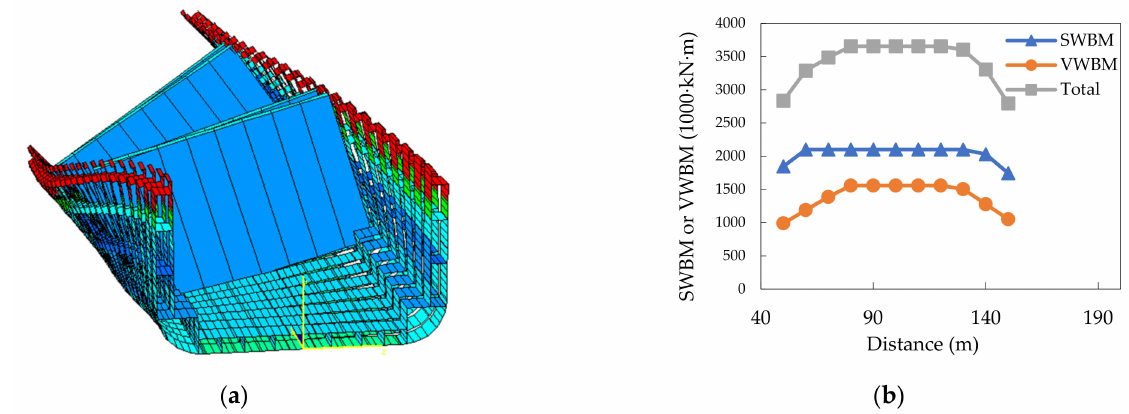
Figure 6. ( a ) 3D cargo hold torsion model, ( b ) bending moment distribution (hogging condition).